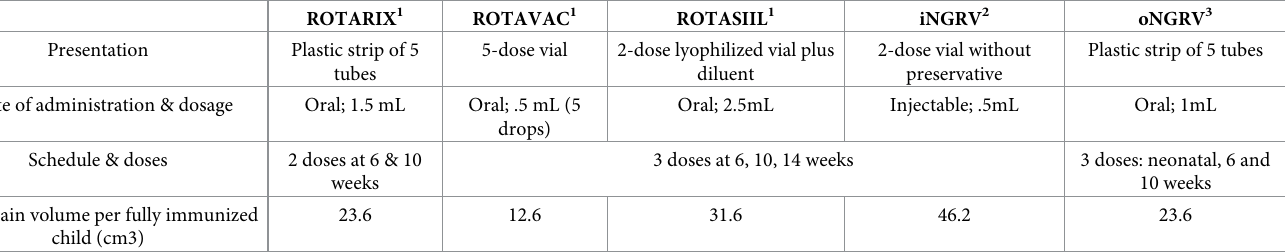
Table 2. Rotavirus vaccine product